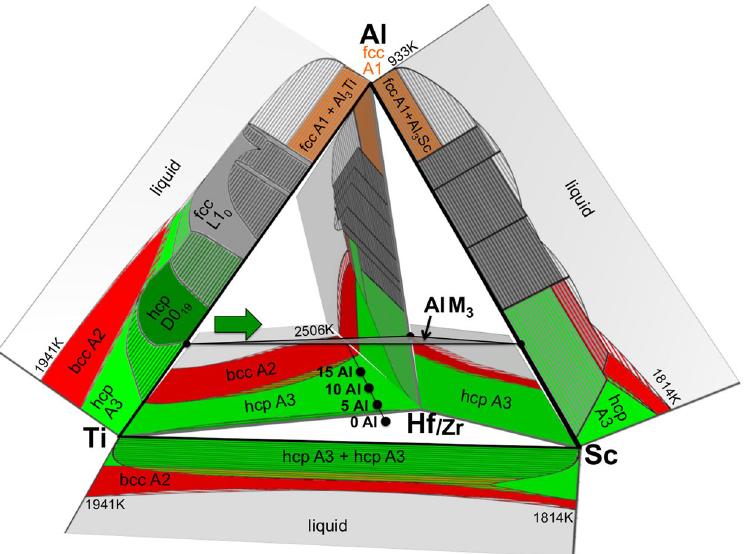
Figure 2. 3D representation of the multi-component phase diagram constructed from the binary diagrams (Fig. 1). For visualization purposes, the Zr-binary phase diagrams (similar to the ones of Hf, see Fig. 1) are not shown. Black filled circles indicate the phase diagram trajectory for varying Al-concentration including the including the main alloy for the ab initio and experimental investigations with 15 at.% Al.